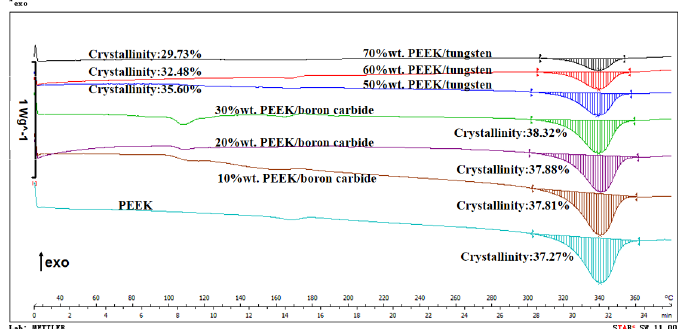
Figure 18. differential scanning calorimeter (DSC) curves of PEEK, PEEK/boron carbide, and Figure18. Differentialscanningcalorimeter(DSC)curvesofPEEK,PEEK / boroncarbide,andPEEK / tungsten PEEK/tungsten composites (DSC 1 STAR e System, METTLER TOLEDO, Shanghai, China). composites (DSC 1 STAR e System, METTLER TOLEDO, Shanghai,